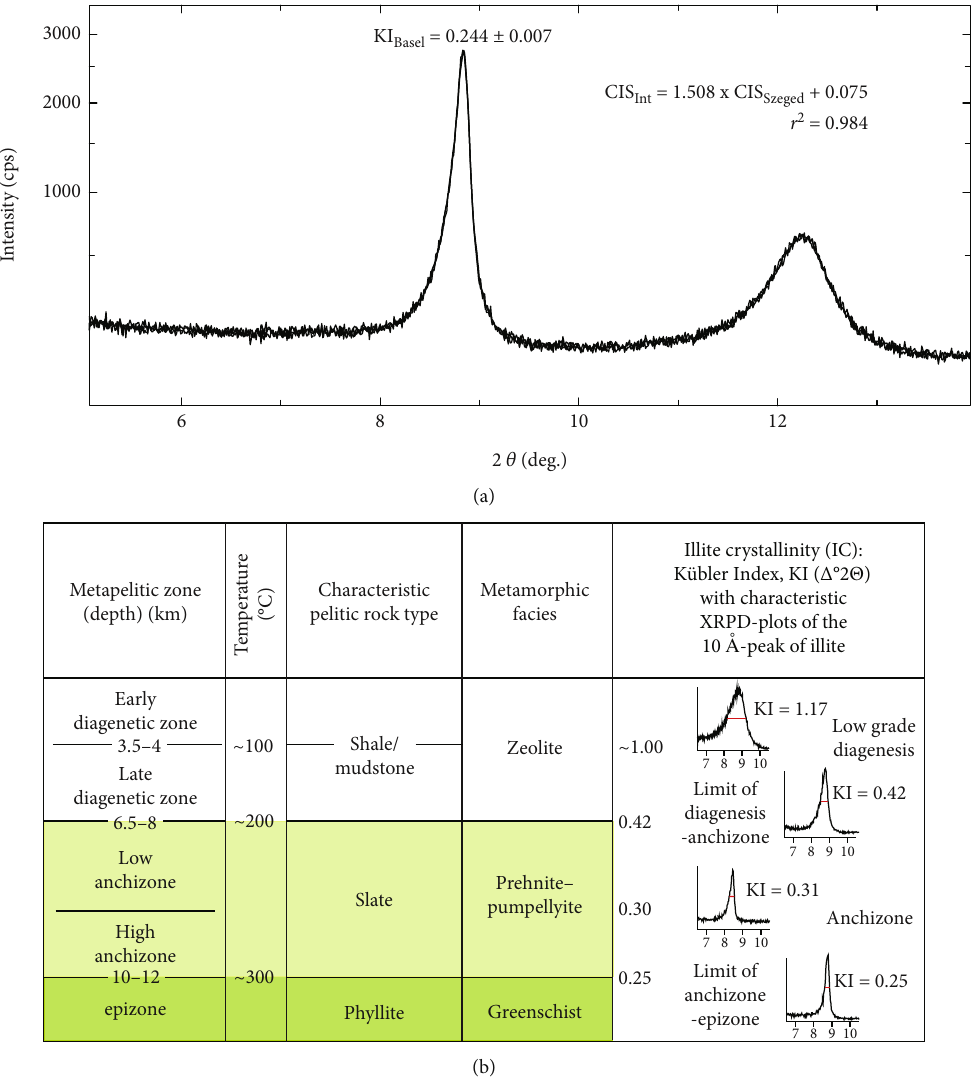
Figure 5: Determination of illite “ Crystallinity Index ” (IC). (a) XRPD patterns of (001) basal re fl ection of the studied red bed (slate) sample measured in triplicate (sample Kel – 14; < 2 μ m fraction, air-dry, highly oriented specimen) used for IC determination. Equation for conversion of own data to KI Basel [39] is also indicated; (b) metapelitic zones showing associated rock types and metamorphic facies. Notice that the correlation with the Kübler Index [39 – 42] is also